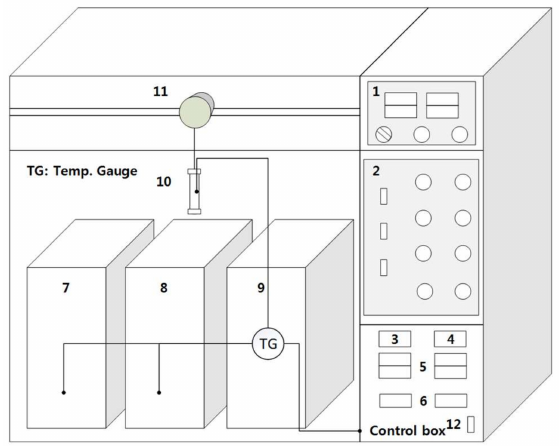
Figure 5. Schematic diagram of the small batch reactor setup: (1) timer and counter; (2) control box; (3) voltmeter; (4) ammeter; (5) thermo-controller; (6) temperature indicator; (7) salt bath; (8) silicon oil bath; (9) cooling bath; (10) batch reactor; (11) electric motor; (12) main switch. First, 0.6 g (oven dry weight) MG and 6.0 mL ethanol (30%, 40%, 50% or 60%, w / v ) were